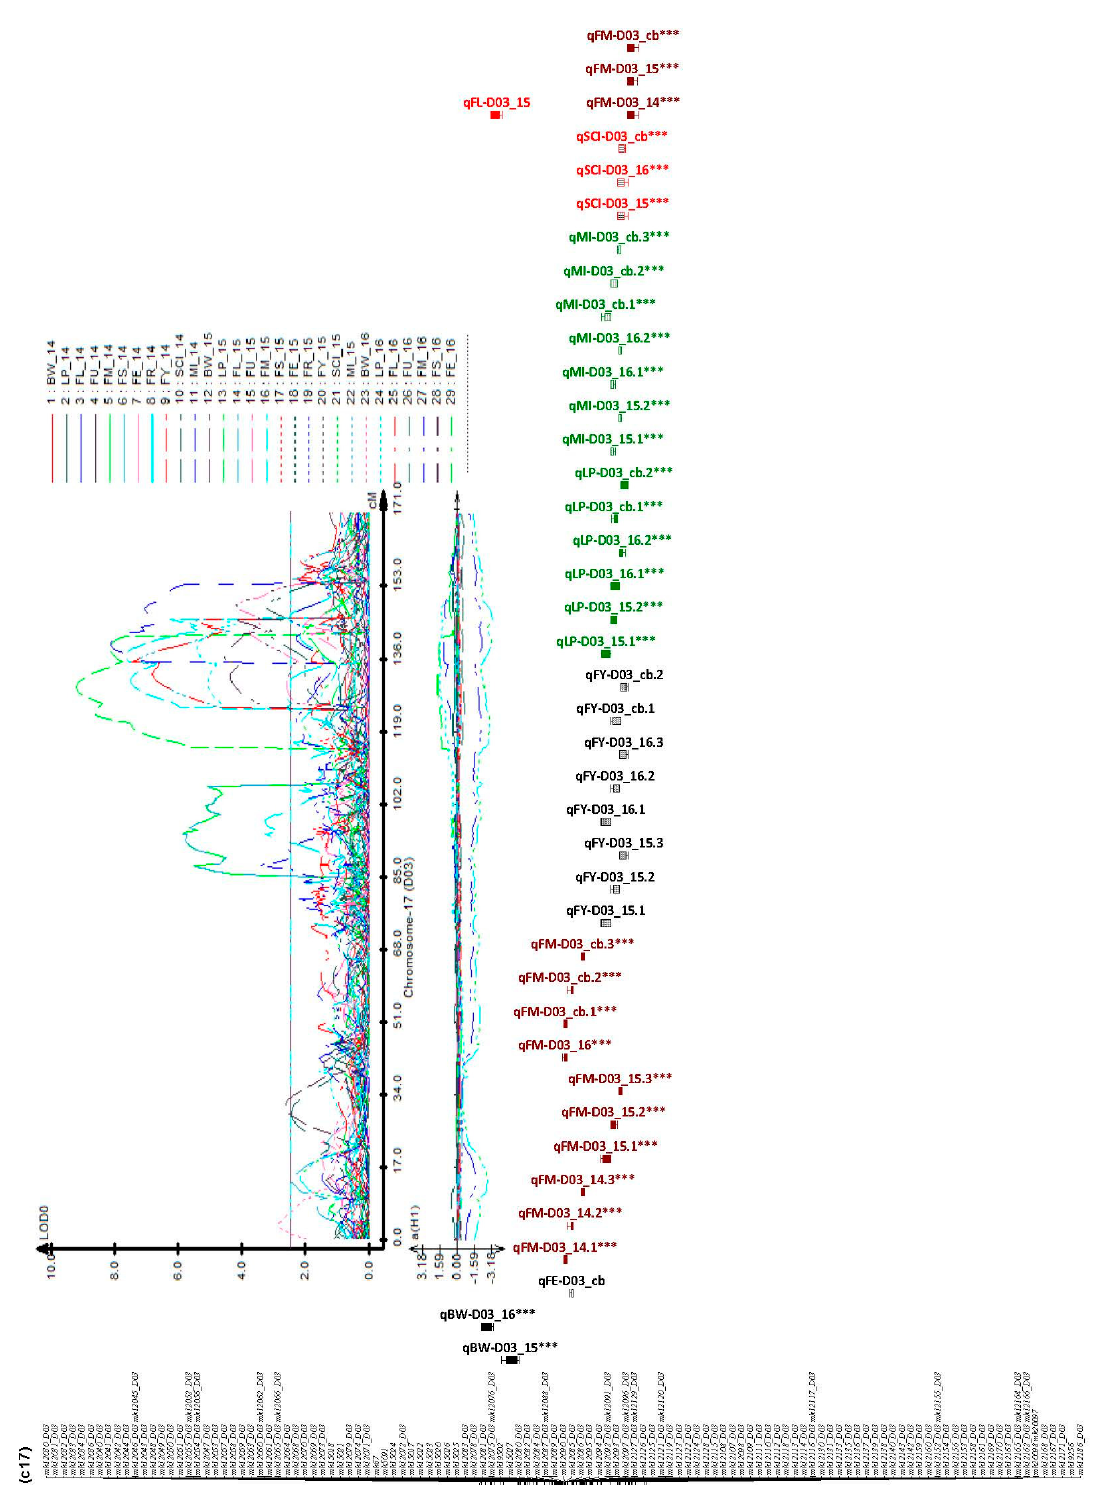
Figure 5. Clustered QTLs identified in D03 (c17) of yield-related and fiber quality traits. Bars and lines on the right-hand side of the linkage groups show the QTL likelihood intervals. Map distances in centiMorgan (cM) are indicated on the left-hand side of the linkage groups. For trait meanings, see Figure 1 or Figure 2, *** asterisk means the QTL is consistent.